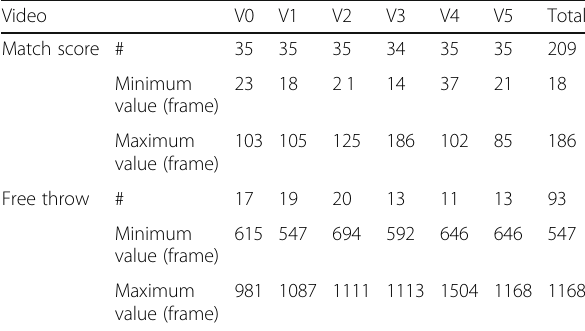
Table 1 Correspondence between the time interval between the suspension of the game and the change of the score with whether the goal is a free throw (video frame rate is 25)